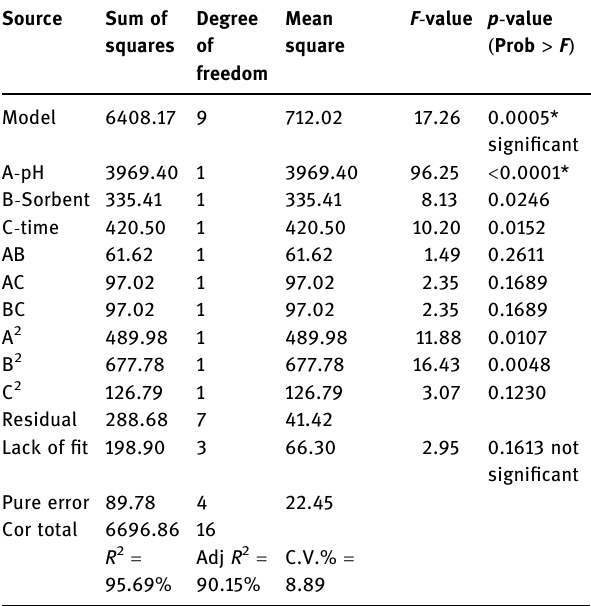
Table 1: Analysis of variance ( ANOVA ) test for the second - order regression model